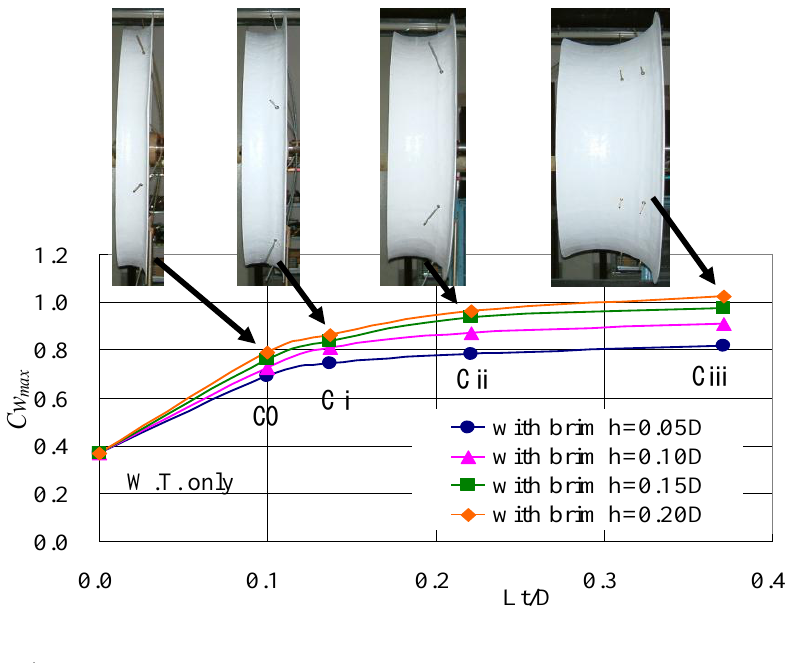
versus C-type wind-lens w, max